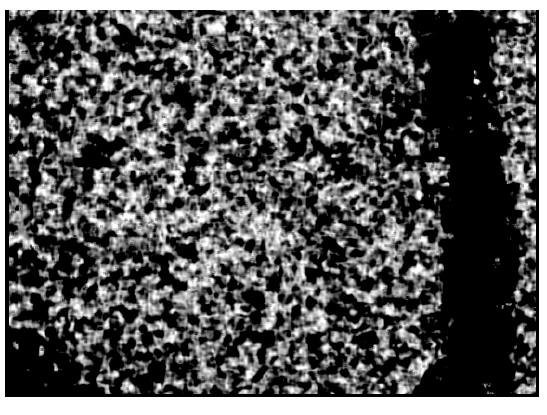
Figure 5. Example of